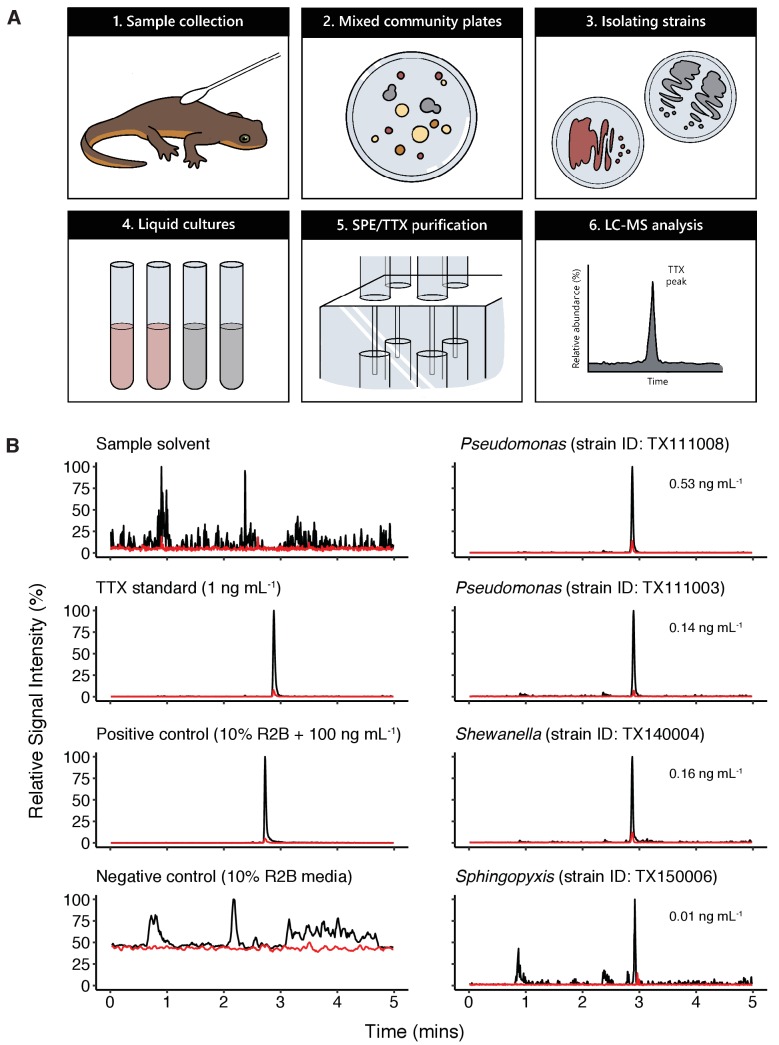
Bacterial isolates cultured from newt skin produce TTX in vitro.(A) Schematic overview of procedure for isolating and screening newt bacteria for TTX production. Bacterial samples were collected from dorsal skin of toxic newts, taxonomically identified by 16S rRNA gene sequencing, grown in liquid culture for 2 weeks, centrifuged, and the supernatant was purified by solid-phase extraction (SPE). Extracts were screened against TTX analytical standards by LC-MS/MS. (B) Representative extracted ion chromatographs showing peaks corresponding to major product ion transitions 320.1 to 162.1 m/z (black) and 320.1 to 302.1 m/z (red) for TTX in cultures from four bacterial isolates. The retention time for each peak was 2.9 min and matched that of both authentic TTX standards and culture media supplemented with 100 ng mL−1 TTX. Peaks were absent in untreated culture media. Estimated TTX concentrations in bacterial cultures are shown next to each peak. Multiple strains of Pseudomonas spp. were found to produce TTX and three additional TTX-producing genera were identified: Aeromonas, Shewanella, and Sphingopyxis.